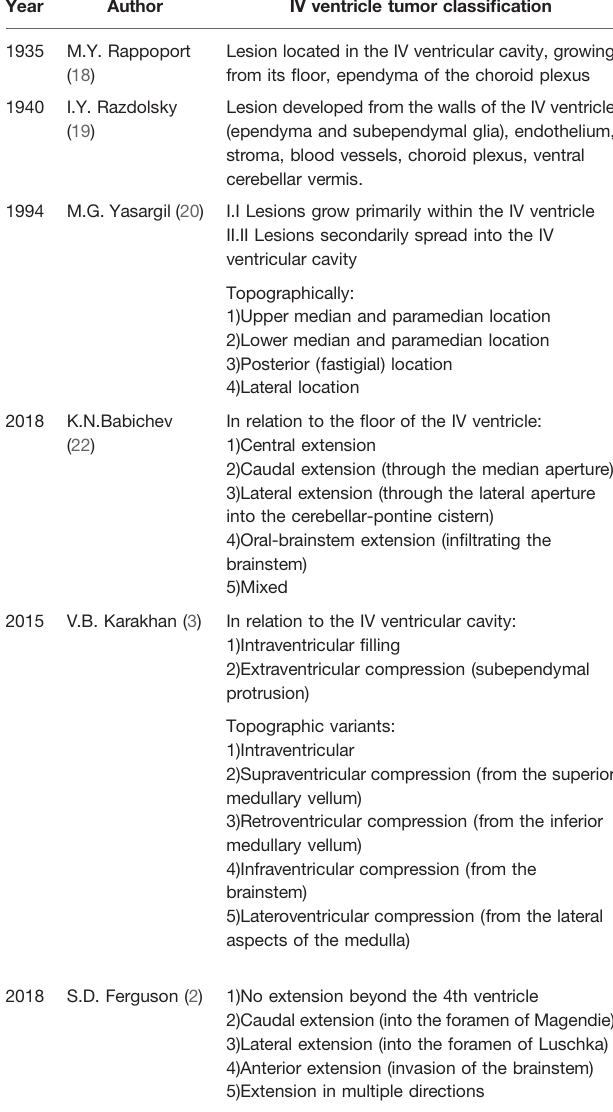
TABLE 2 | IV ventricle tumor classi fi